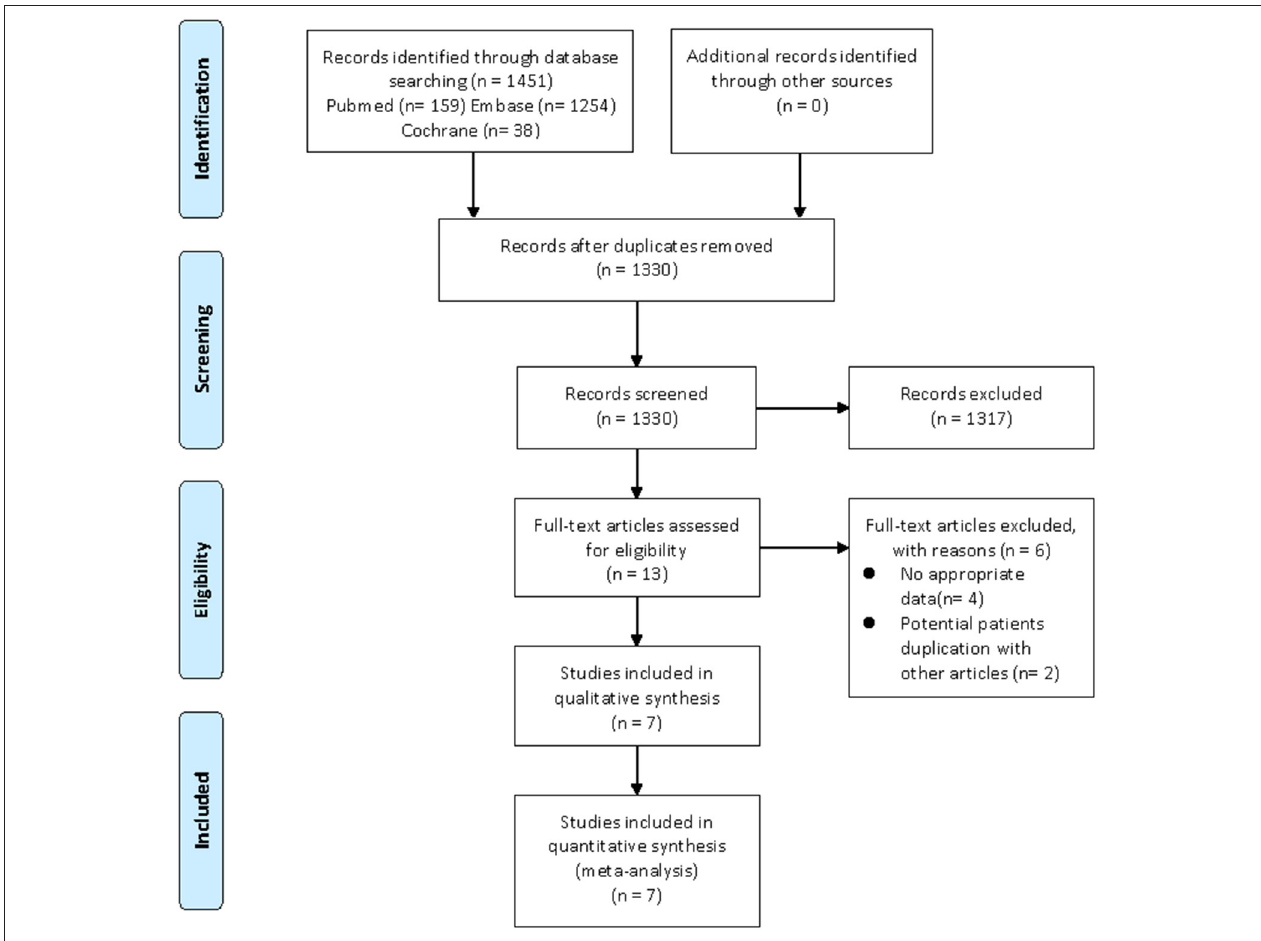
FIGURE 1 | Flow diagram of the selection process for studies on CHD risk. From Moher et al.